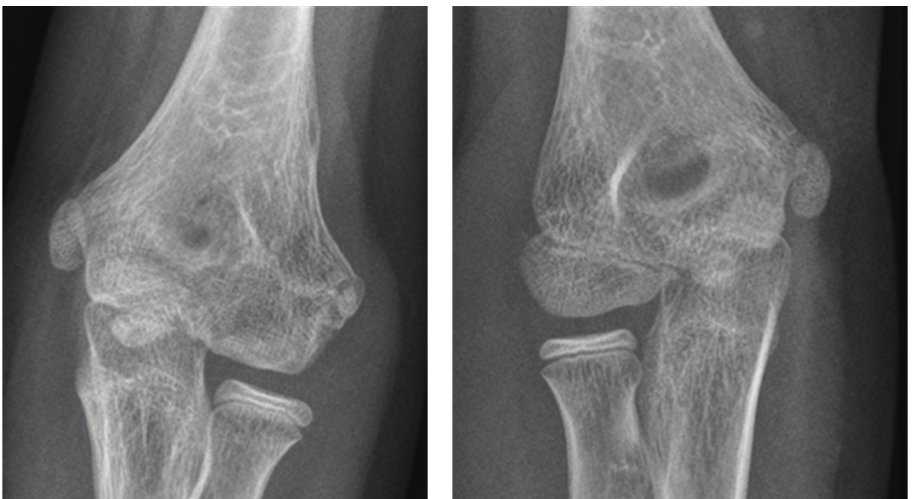
Figure 1: Fractured elbow compared to the contralateral healthy elbow at 4-year followup (group 1).